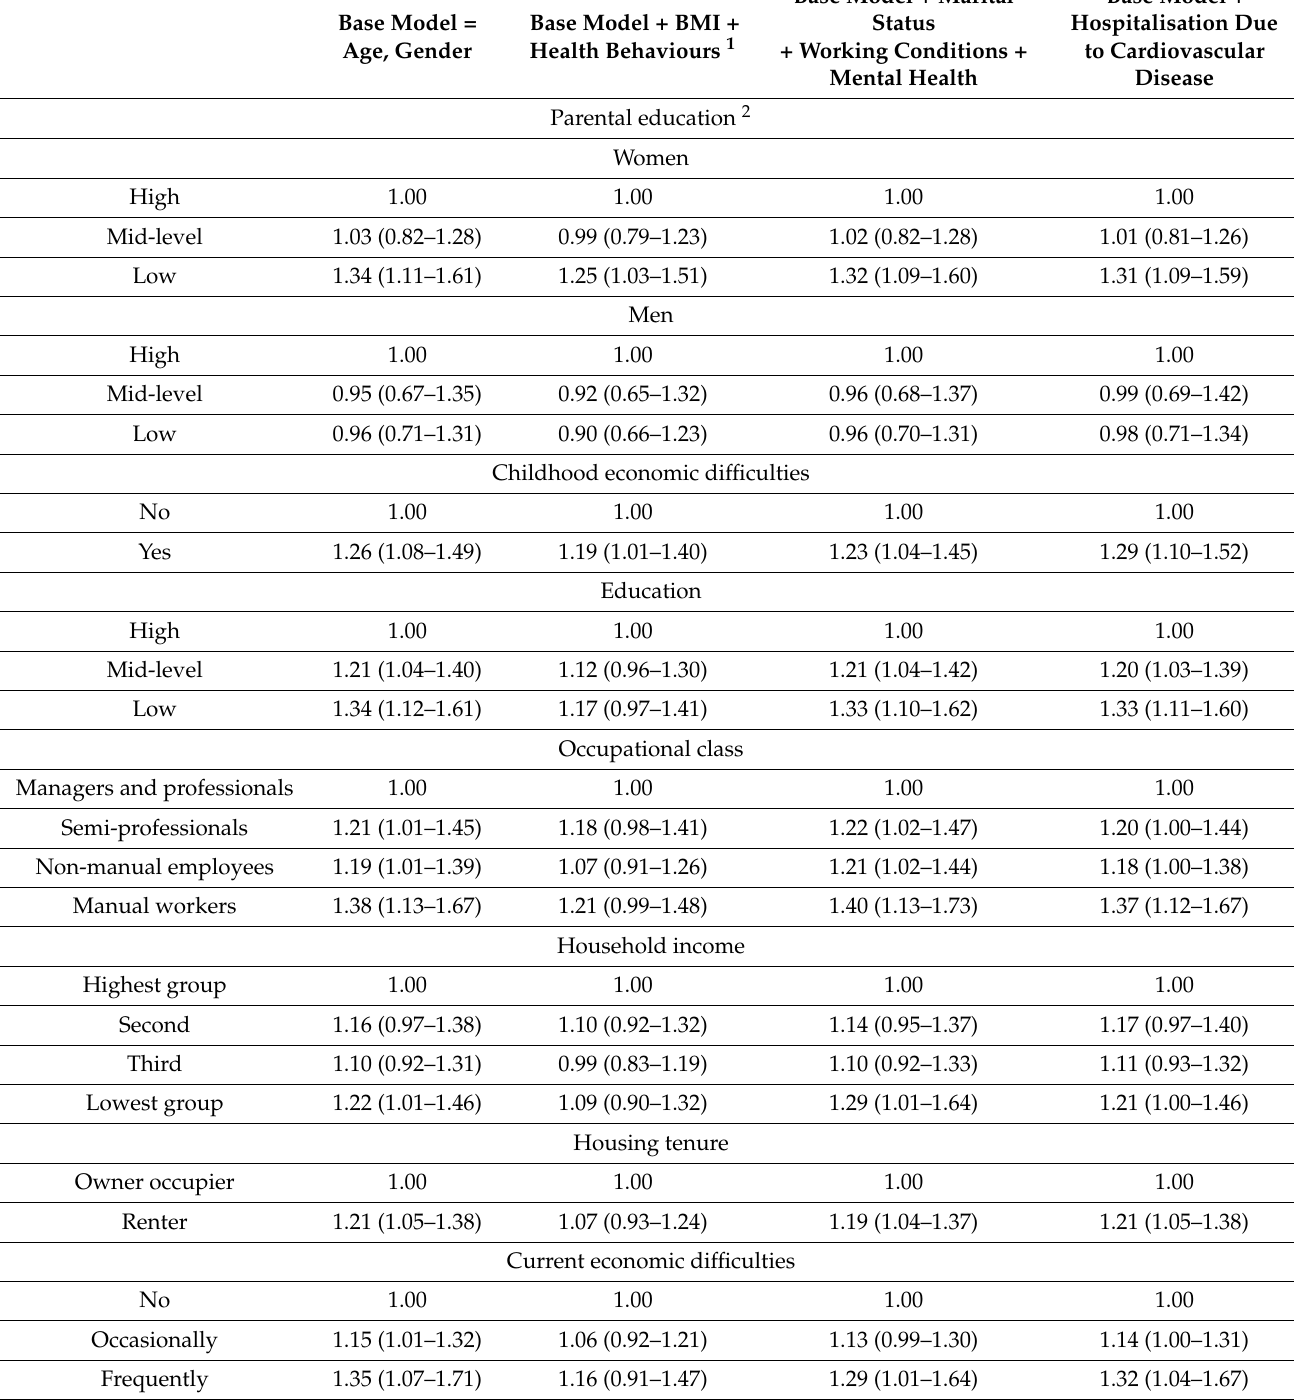
Table 3. The associations between socioeconomic circumstances and lipid medication. Odds ratios and 95% confidence